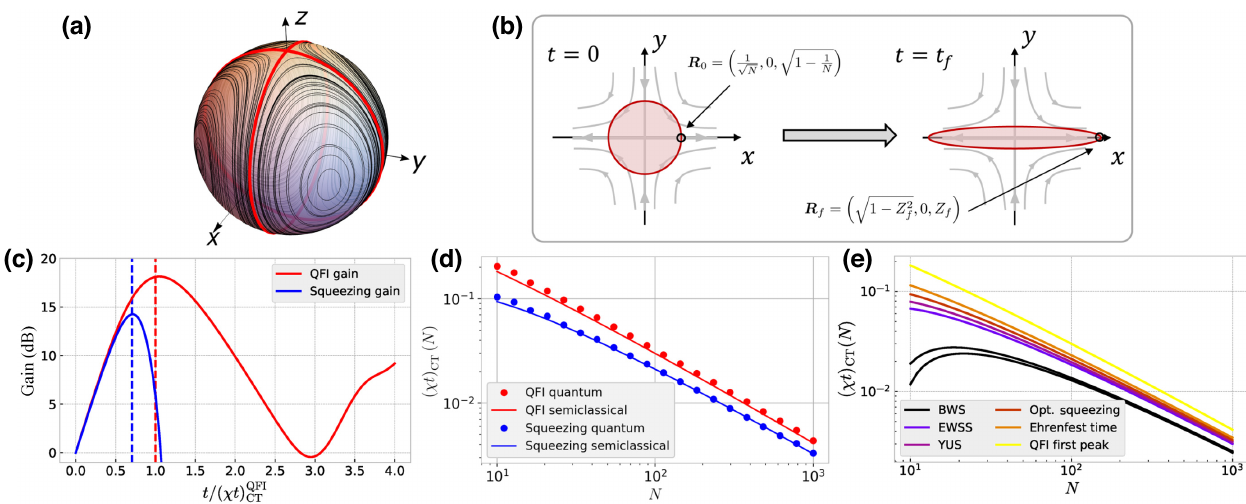
FIG. 2. (a) Phase-space portrait of the 2ACT phase-space flow in the thermodynamic limit; cf. Eqs. (8). The red trajectory shows the separatrix. (b) Semiclassical picture for the dynamics of a spin coherent state located at the saddle point of the corresponding classical phase-space flow. (c) Metrological gains based on spin squeezing (solid blue) and QFI (solid red) for the 2ACT dynamics. The dashed lines show the time to the peak of each metrological gain computed in the main text. The results shown are for N = 100. (d) Comparison between analytical estimates and exact numerical simulations of the time required to peak QFI and spin squeezing for the 2ACT dynamics. (e) Time scales to different metrologically relevant quantum states prepared with 2ACT dynamics as a function of N . For the Yurke state, we consider α =